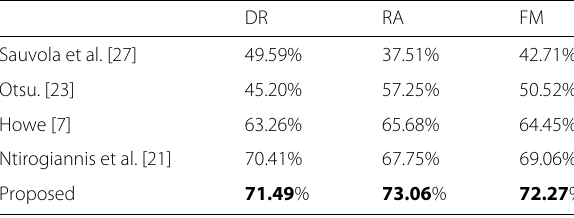
with conventional binarization methods